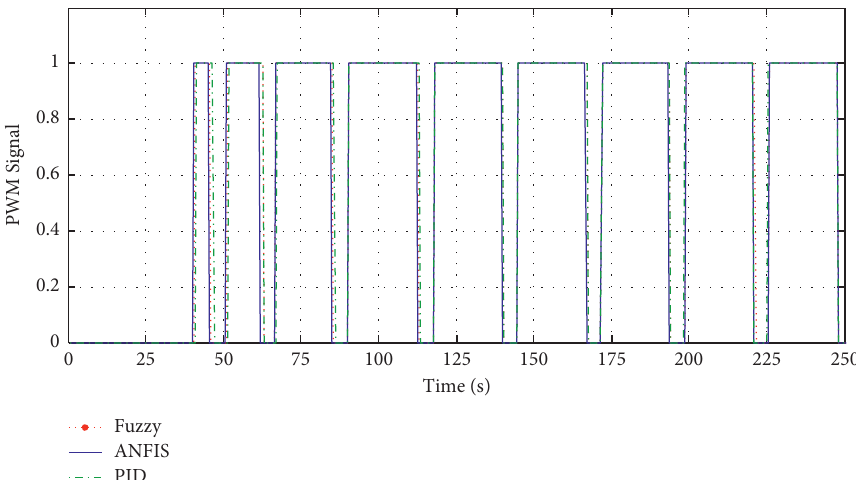
Figure 18: PWM signal of all three ANFIS controllers, Fuzzy, and PID, in “step” reference input mode.